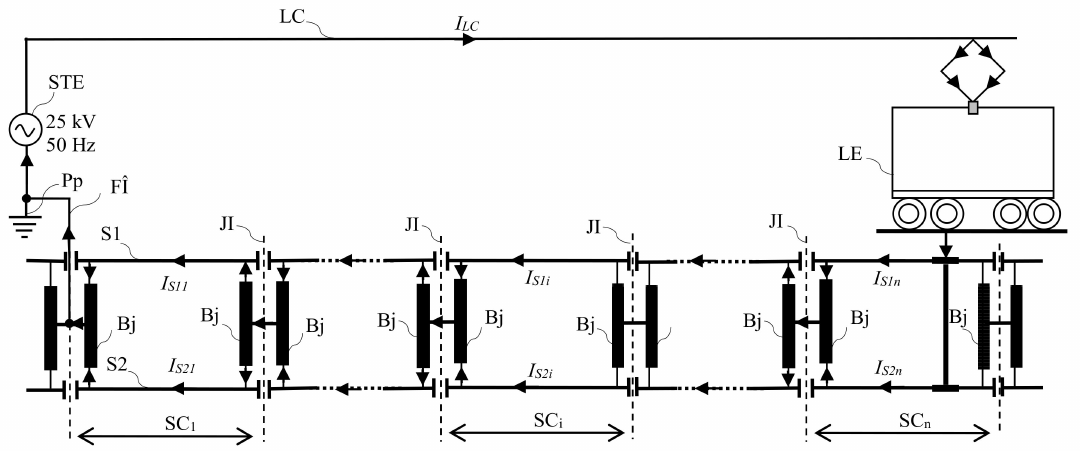
Figure 3. The structure of a power supply system from railway